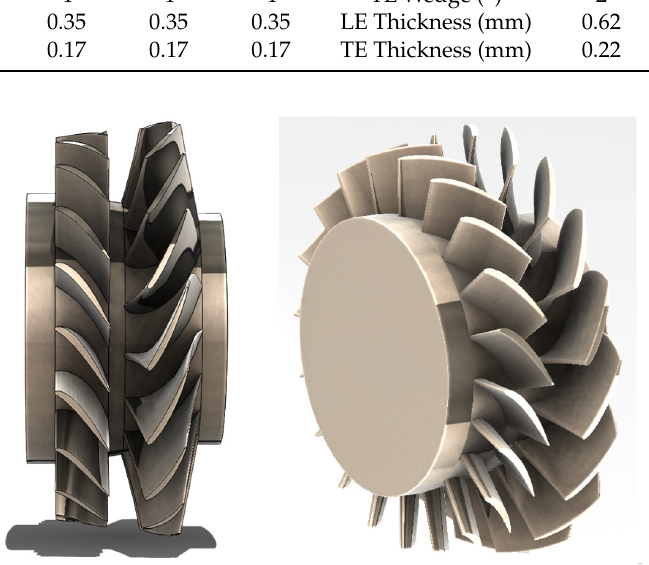
Figure 11. 3-D full view of preliminary design generated.